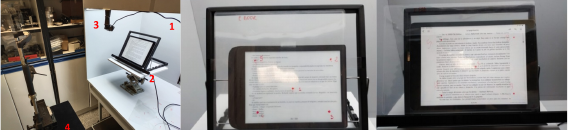
Figure 1. Left: Arrangement of the study elements. 1) Colour assessment cabinet. 2) Platform with the lectern where the eye- tracker and the reading device were placed. 3) Camera. 4)